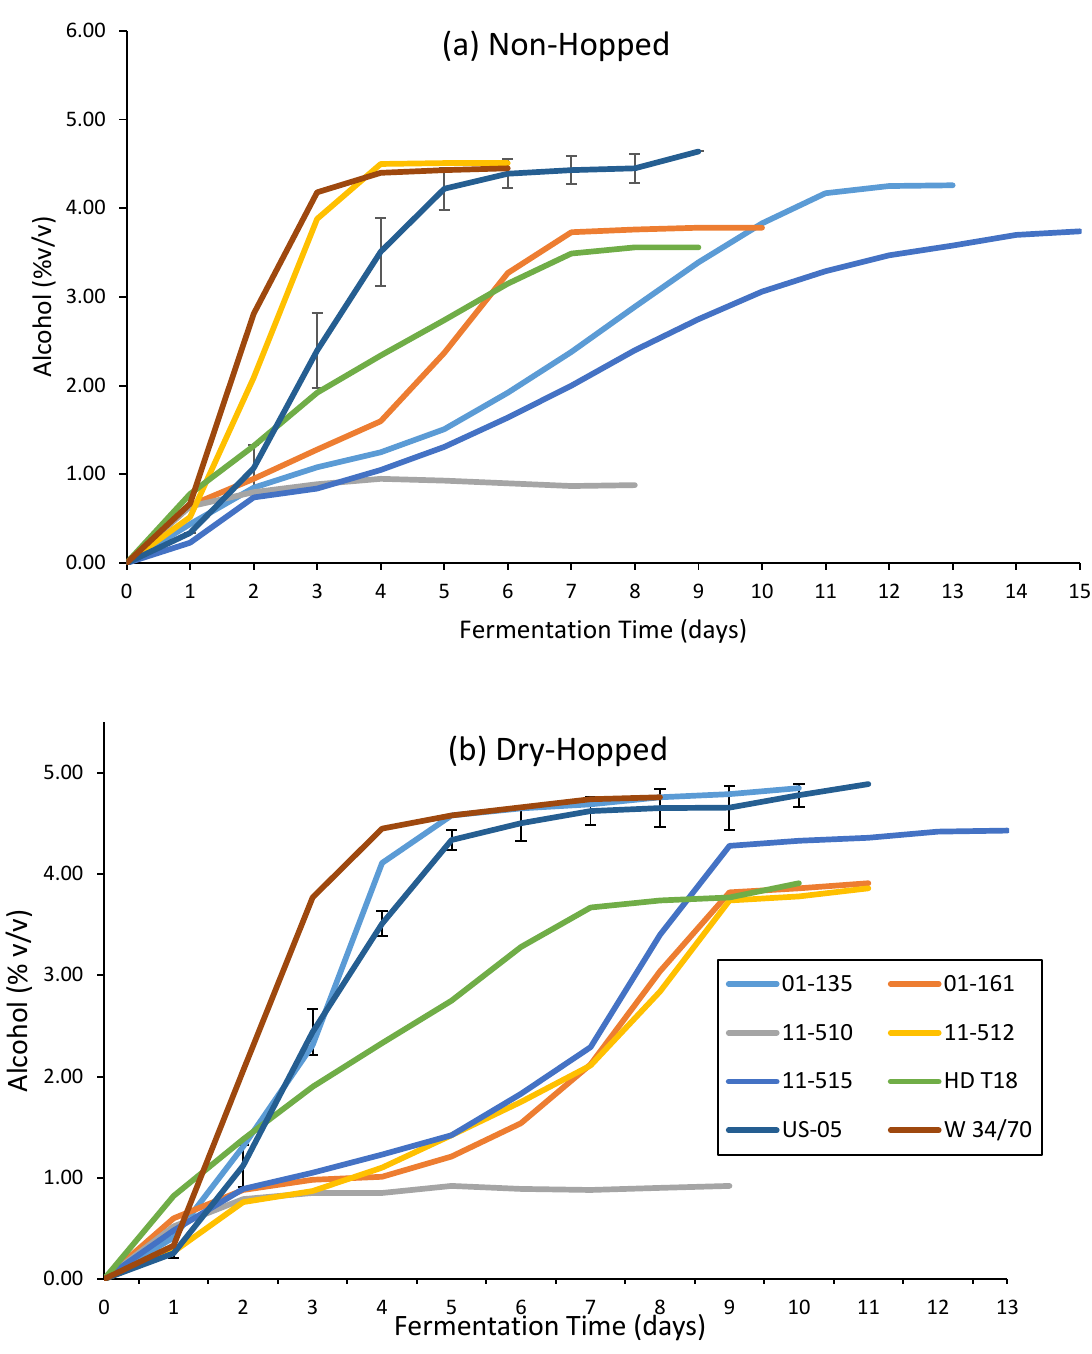
Figure 3. Alcohol content by volume measured daily on the Anton Paar Alcolyzer Beer M, as reported for both ( a ) non- hopped and ( b ) dry-hopped fermentations of all yeasts in this study. Results for US-05 are reported as the mean of three biological replicates with error bars for standard deviation at each day of fermentation.